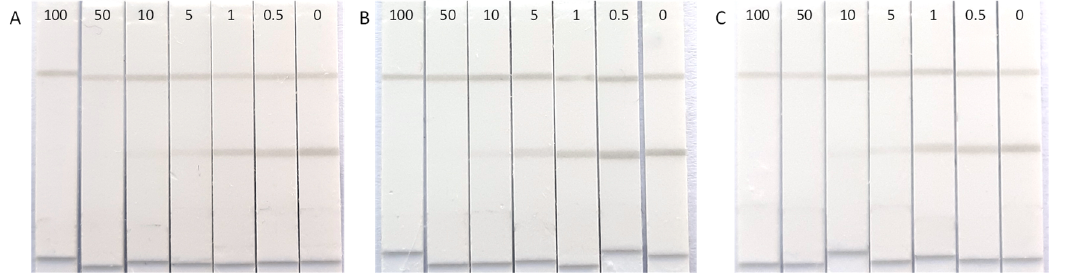
Figure 2. Sensitivity testing of the CHLP LFIAs by applying CHLP standards (0.5 to 100 µg/L) in three independent runs ( A – C ) within one day with a two hour interval between each run.